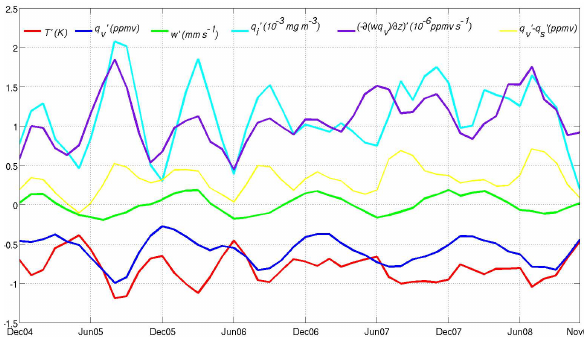
Fig. 6. The time series of monthly averaged differences between the WRF CTRL and UTNR simulations at 100hPa. Temperature (K) difference in red; water vapor (ppmv) difference in blue; ver- tical velocity (mm s − 1 ) difference in green; ice water content (10 − 3 mgm − 3 ) in cyan; vertical water vapor flux ( 10 − 6 ppmvs − 1 ) in purple; the difference between water vapor dif- ference and saturation water vapor difference ( q 0 v − q 0 s ; ppmv) in